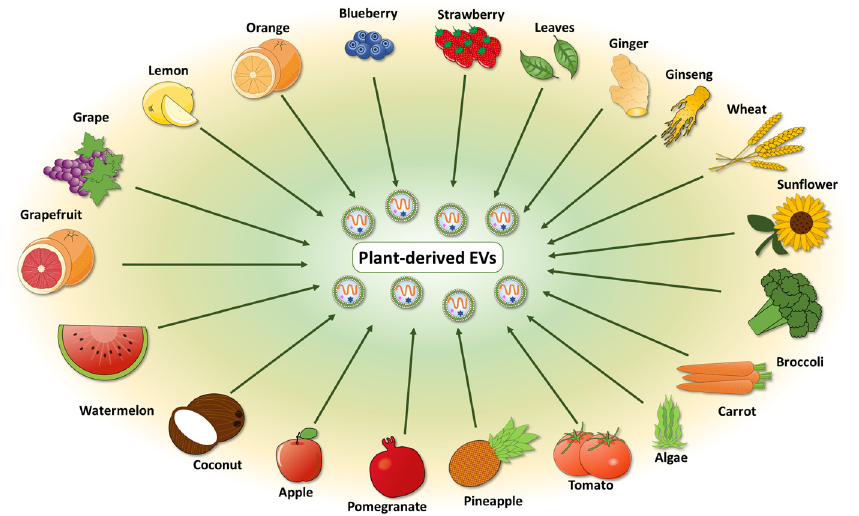
Figure 3. The sources of plant-derived extracellular vesicles. PDEVs can be isolated from various edible plants, such as fruits and vegetables. The starting matrix can be represented by tissues or organs, juice, leaves, seeds, and roots.